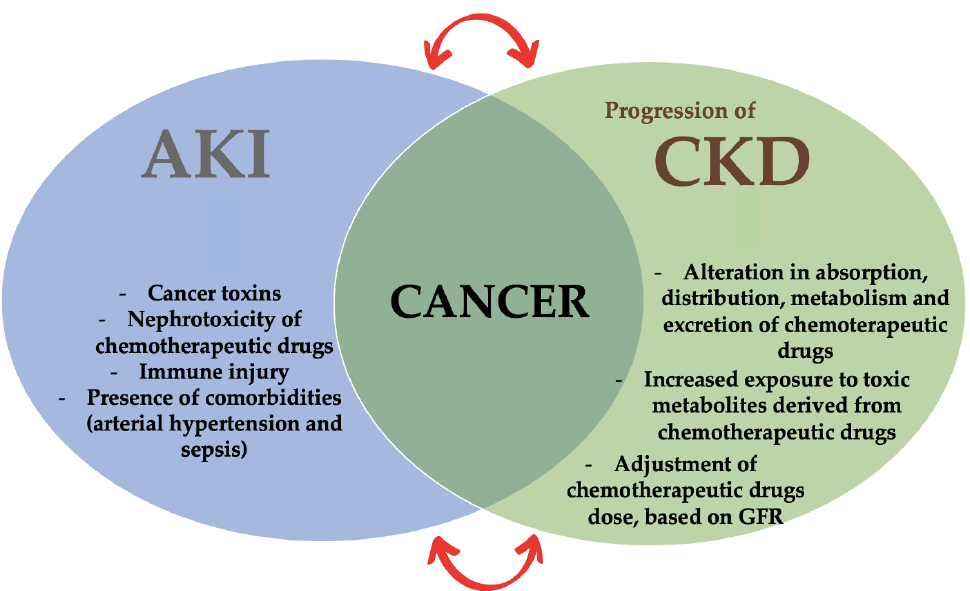
Figure 1. The new medicine field of onco-nephrology.